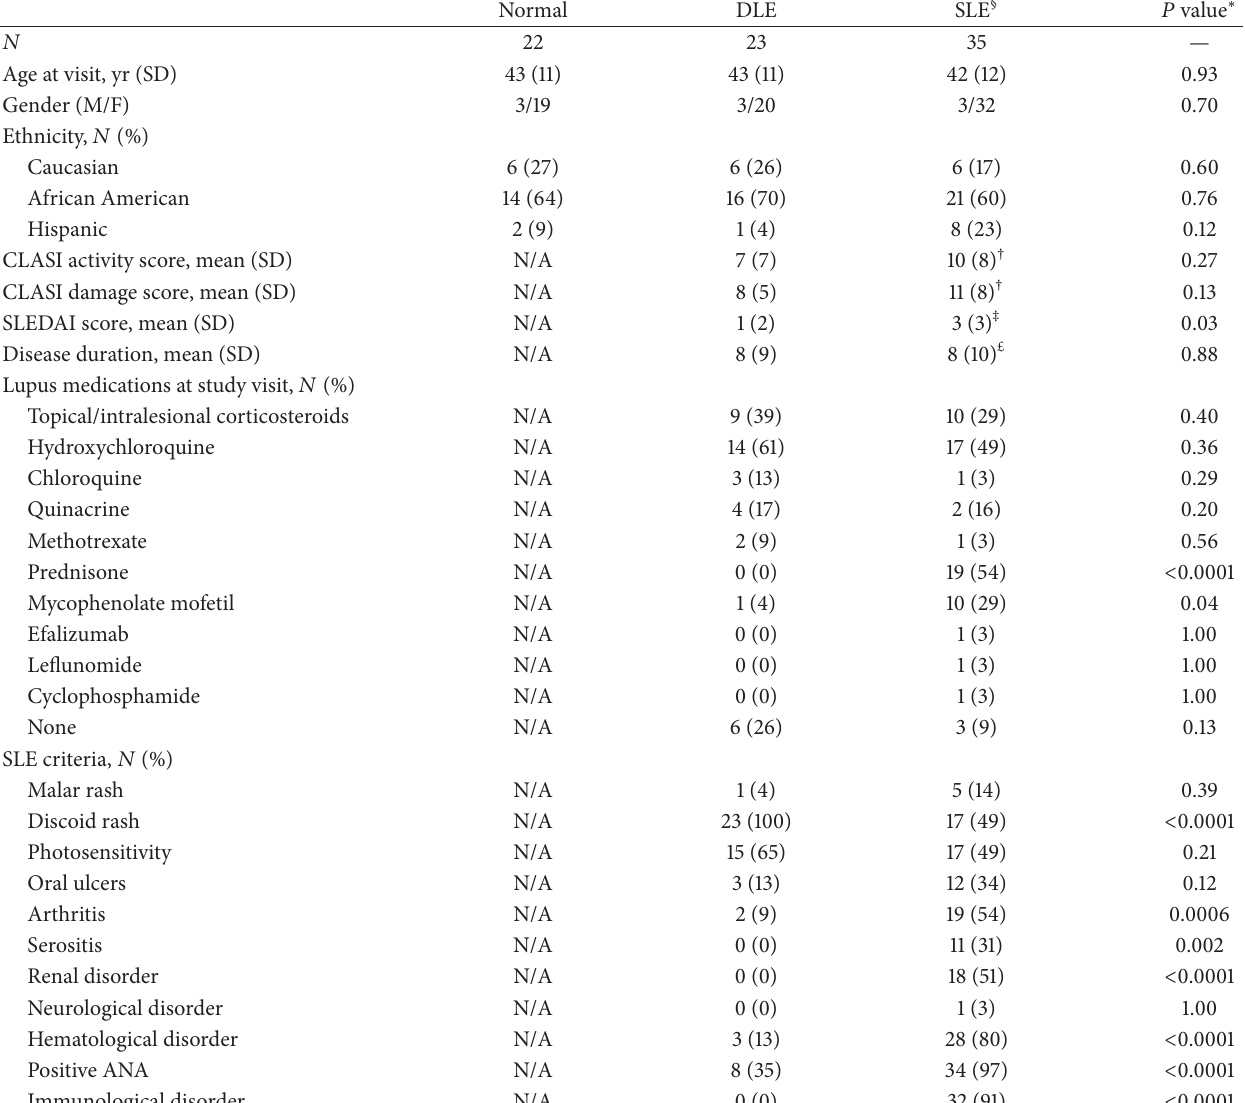
Table 1: Patient